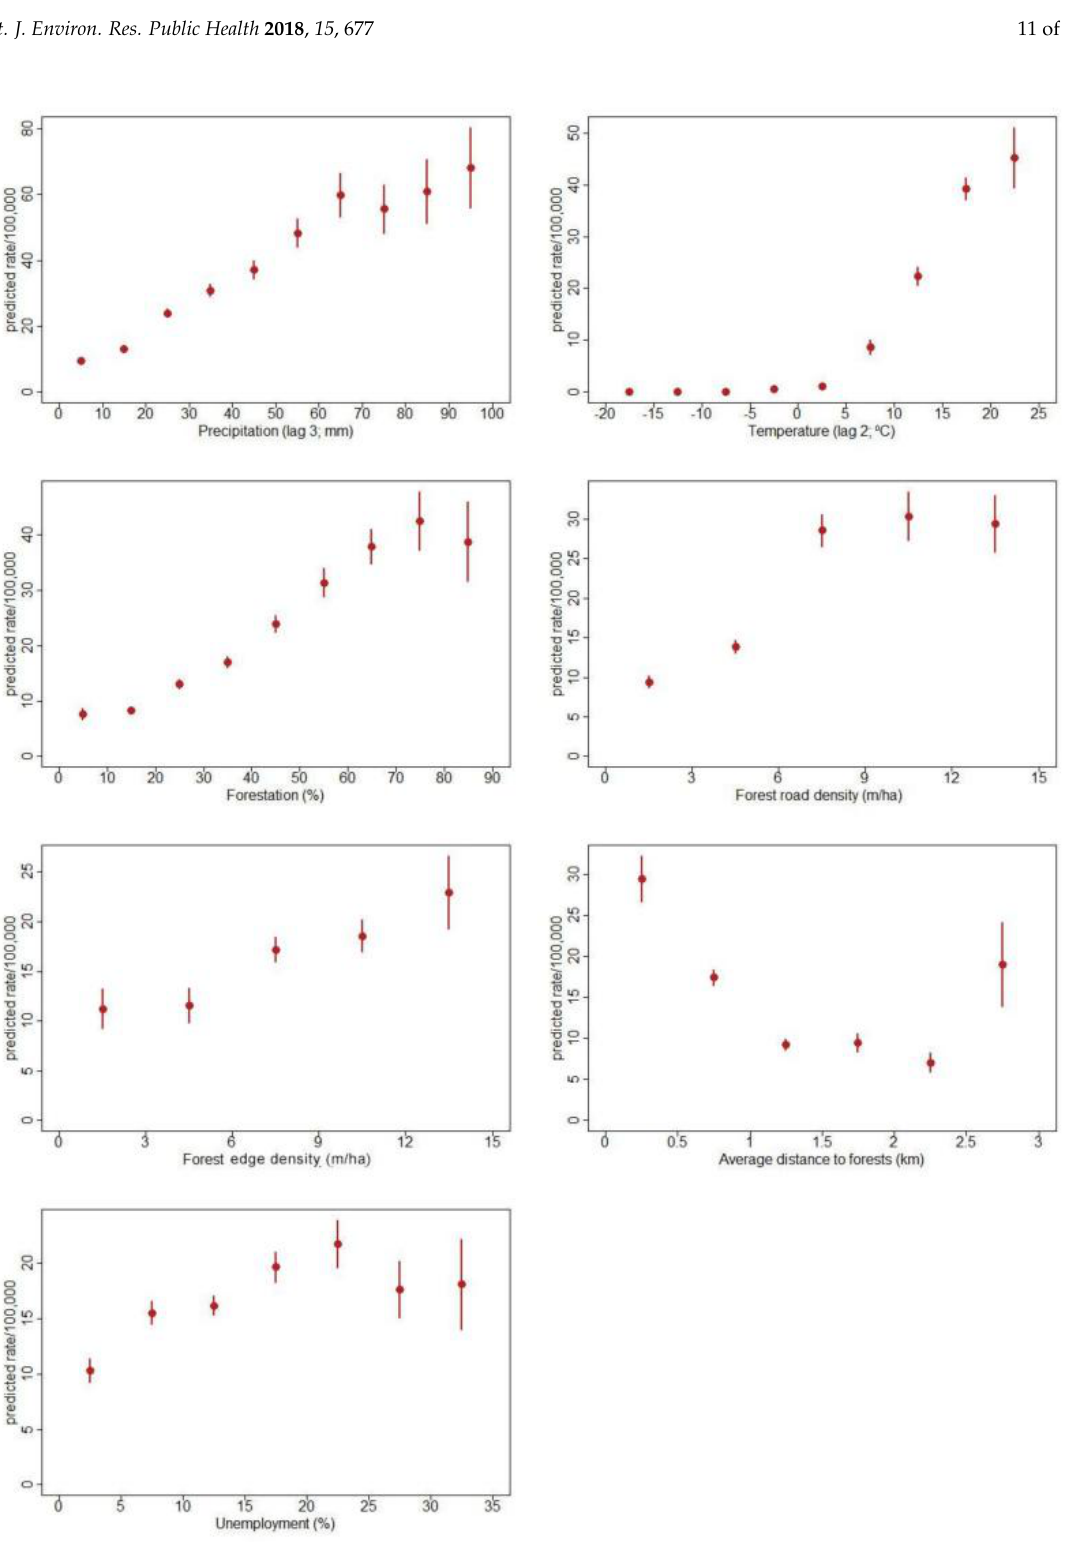
Figure 4. TBE predicted rates estimated at fixed values of continuous variables and stratified by categorical variable levels (forest edge density) (marginplots), 108 endemic municipalities,